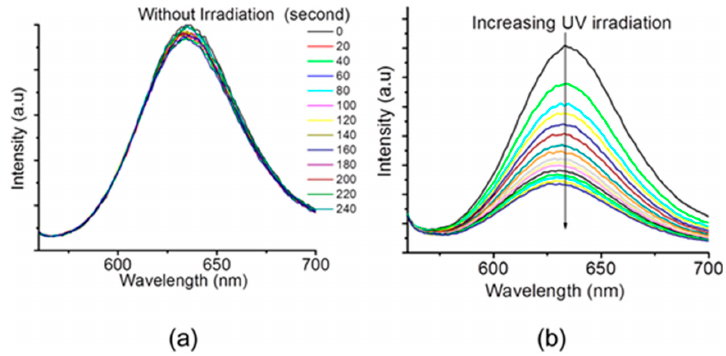
Figure 5. The Polymersomes as carriers for light-controlled release of hydrophobic drugs, NR: ( a ) Emission spectra of NR for the polymersomes solution without UV irradiation; ( b ) Emission spectra of NR for the polymersomes solution under UV irradiation at 365